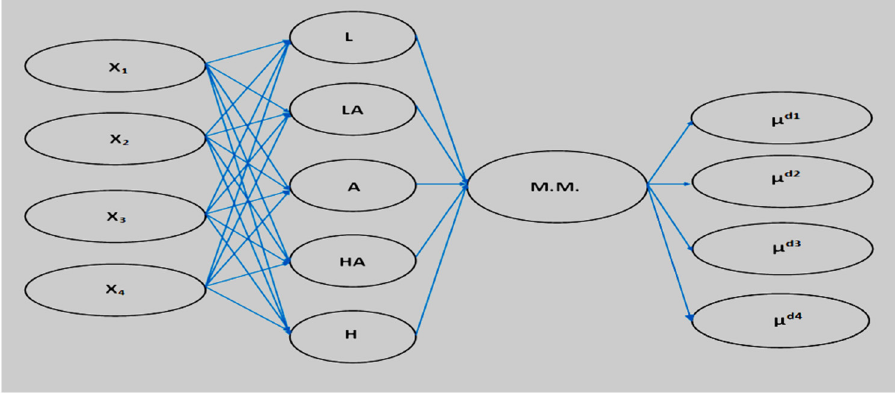
Figure 5. Medical expert system for determining the degree of anatomical lesion of the coronary arteries.